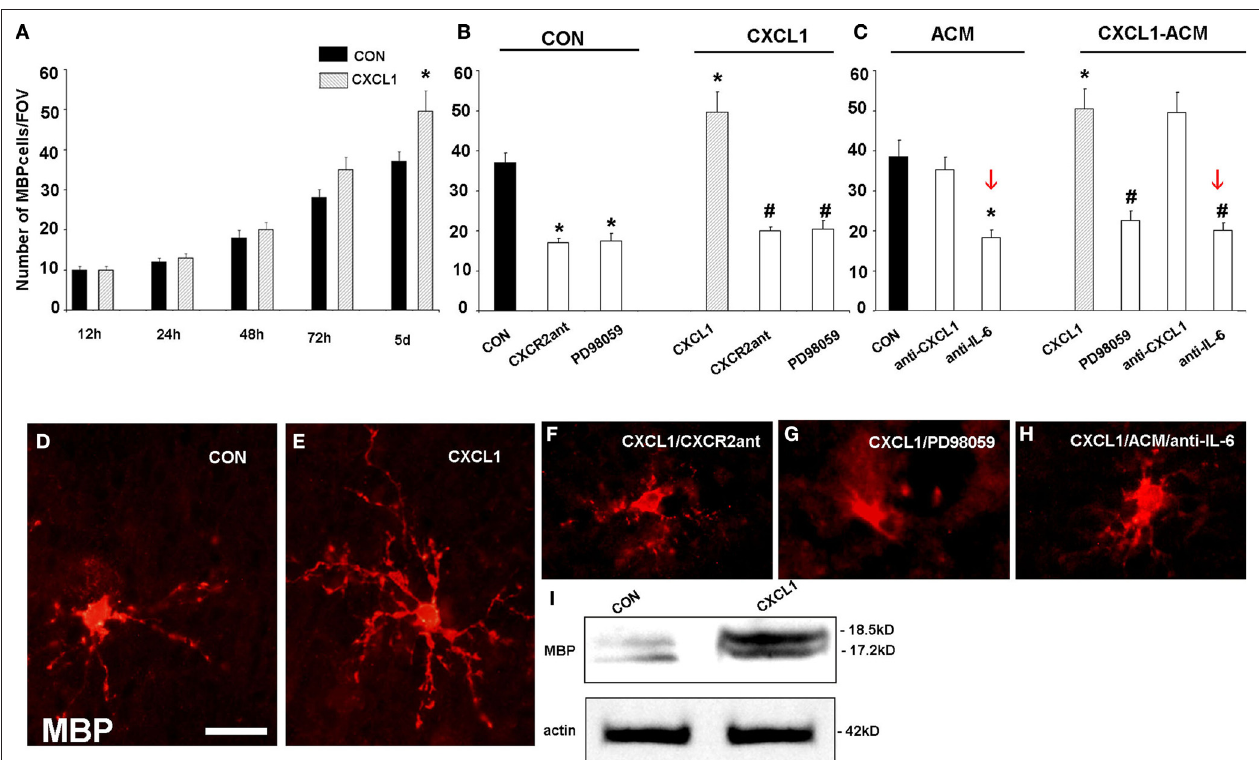
FIGURE 9 | Effect of CXCL1 on the differentiation of oligodendrocyte progenitors in slice cultures from VZ/SVZ region at midgestation. (A) Time- dependent effect of CXCL1 on the number of MBP + oligodendrocytes (OLs) per fi eld of view (FOV). OL number is signifi cantly different between control (CON) and CXCL1 treated slices after 5 div ( n = 7, * P < 0.05 vs. control slices) (B, C) The number of OLs in different experimental conditions after 120 h in vitro. (B) Decreased number of OLs is observed after inhibition of CXCR2 receptor or ERK1/2 pathway in CON and CXCL1 treated slices ( n = 7, * P < 0.05 vs. controls, # P < 0.05 vs. CXCL1 treated slices). (C) Treatment of slices with CXCL1 stimulated astrocyte conditioned medium (CXCL1/ACM) signifi cantly increases the number of OLs, as compared to conditioned medium from unstimulated